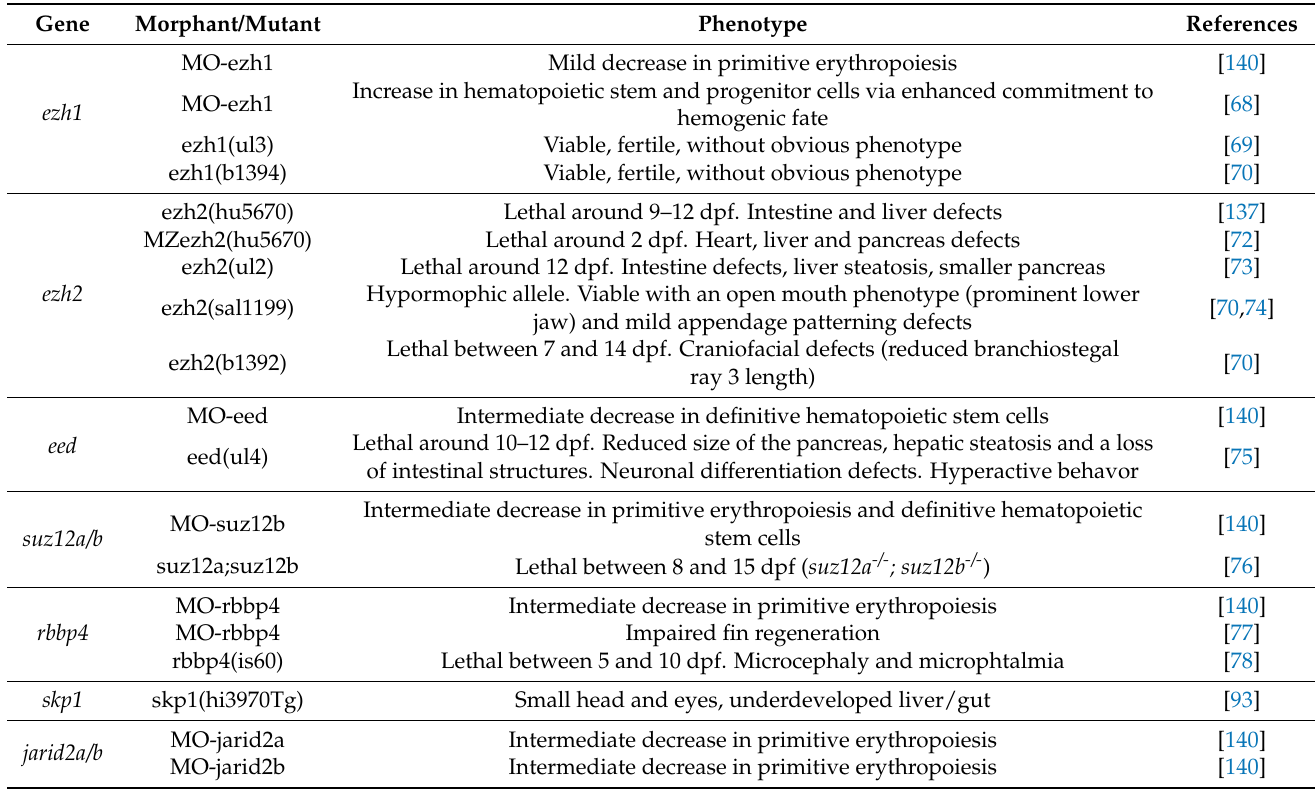
Table A1. Phenotypes of the PRC1/PRC2 morphants and